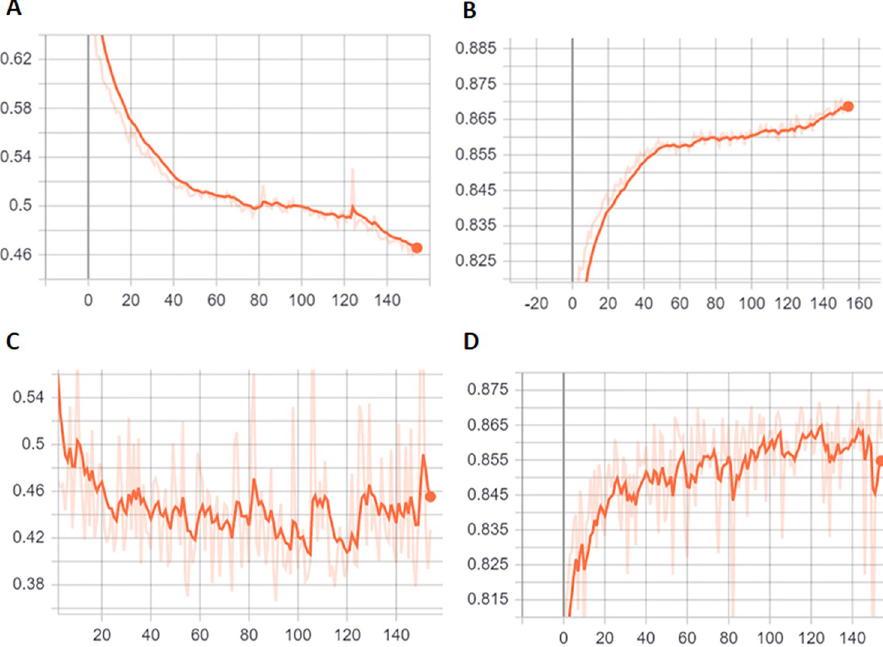
Fig 4. Training and validation process of DRCNN, with training cross-entropy loss (A), training accuracy (B), validation cross-entropy loss (C) and validation accuracy (D) are presented.